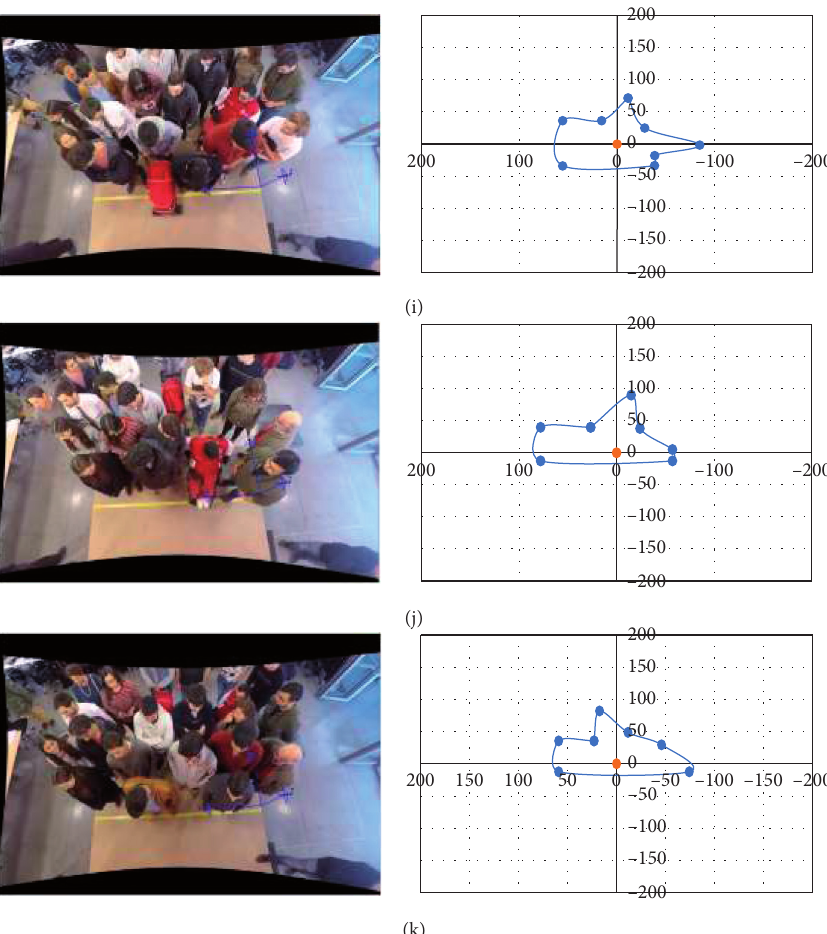
Figure 12: Graphical representation of space (measured in cm) occupied by a passenger without disability in the case of 4.0passengers/m 2 (11